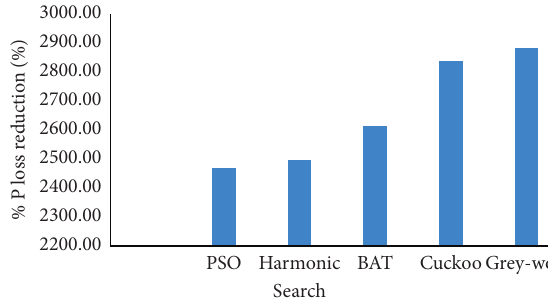
Figure 15: Power loss reduction for different techniques. Table 2: Comparison of metaheuristic